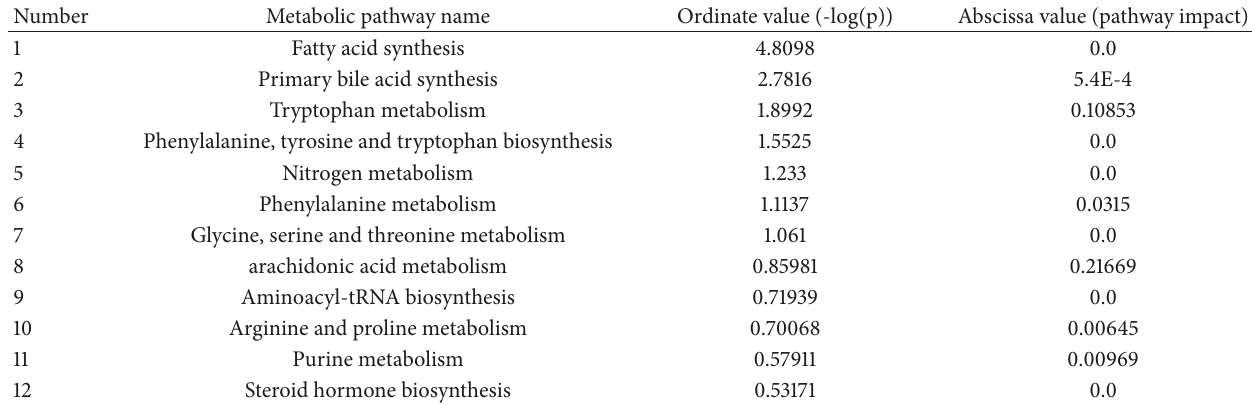
Table 10: Metabolic pathway name and distribution